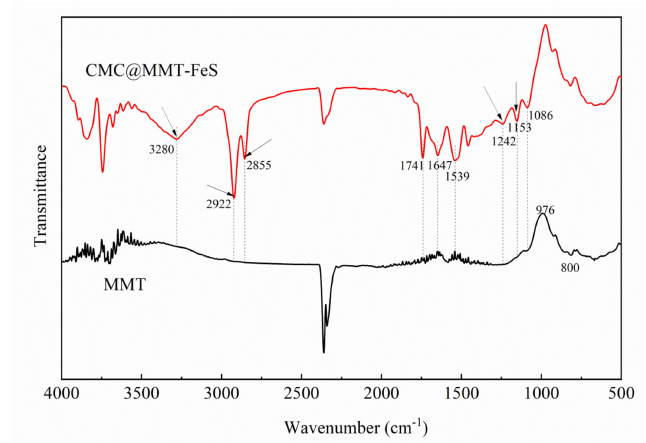
Figure 2. Fourier transform infrared spectral pattern analyses of montmorillonite (MMT) and